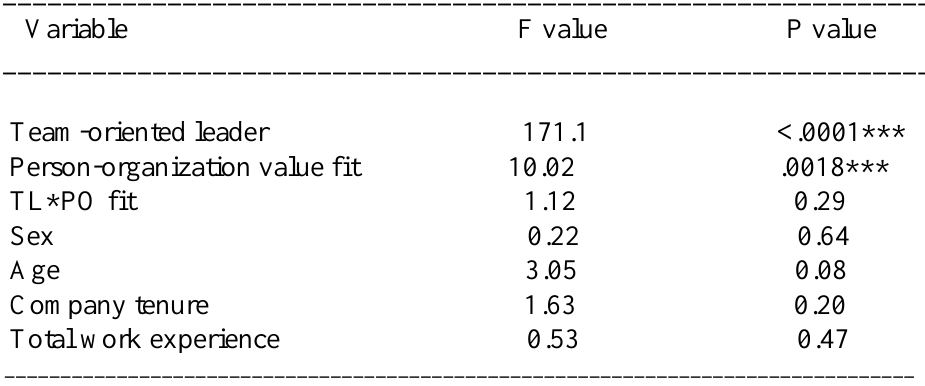
Table 4: Dependent Variable = Employee Trust in Their